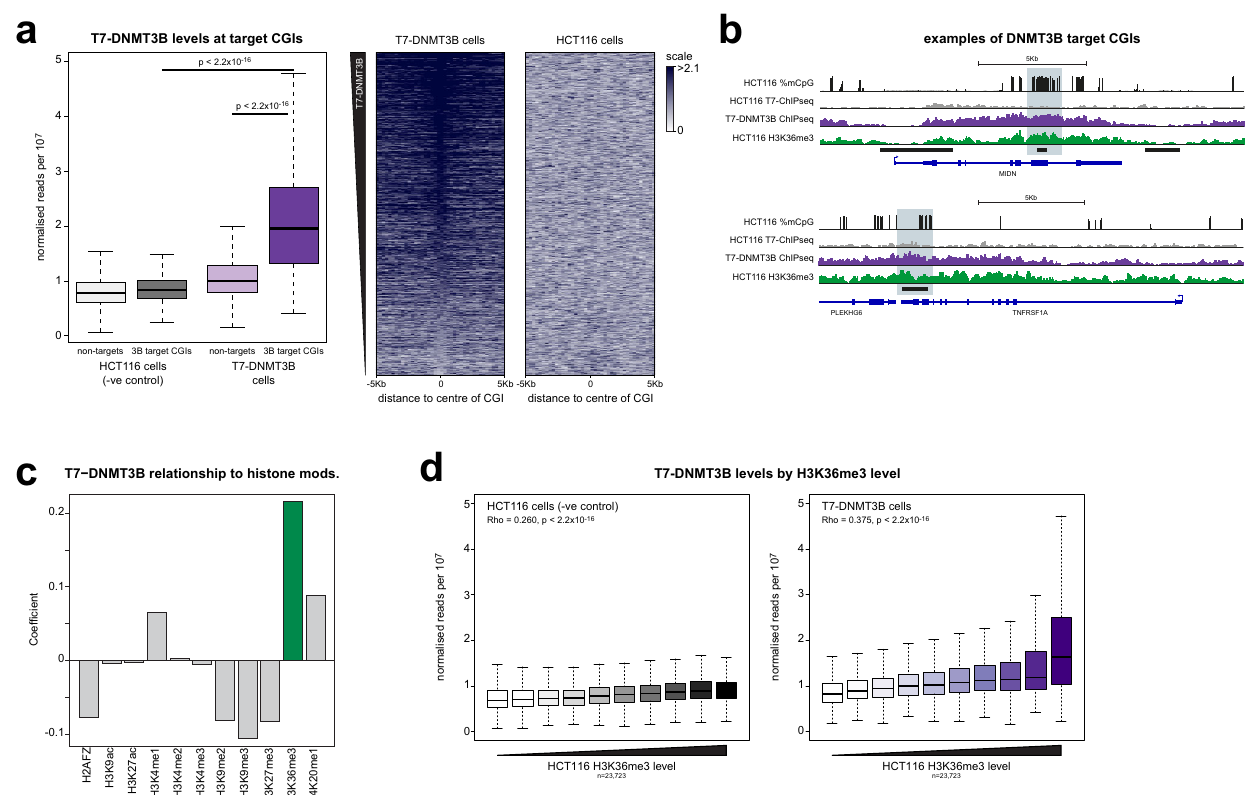
Fig. 3 DNMT3B is recruited to H3K36me3 marked CGIs. a DNMT3B localises to CGIs that gain methylation upon DNMT3B expression in DKO cells. Left, boxplot comparing levels of DNMT3B at putative DNMT3B targets ( n = 2238) and other CGIs ( n = 19,939). Right, heatmap showing measured DNMT3B around putative DNMT3B targets compared to the background in HCT116 cells where DNMT3B is untagged. Both panels show the mean of two